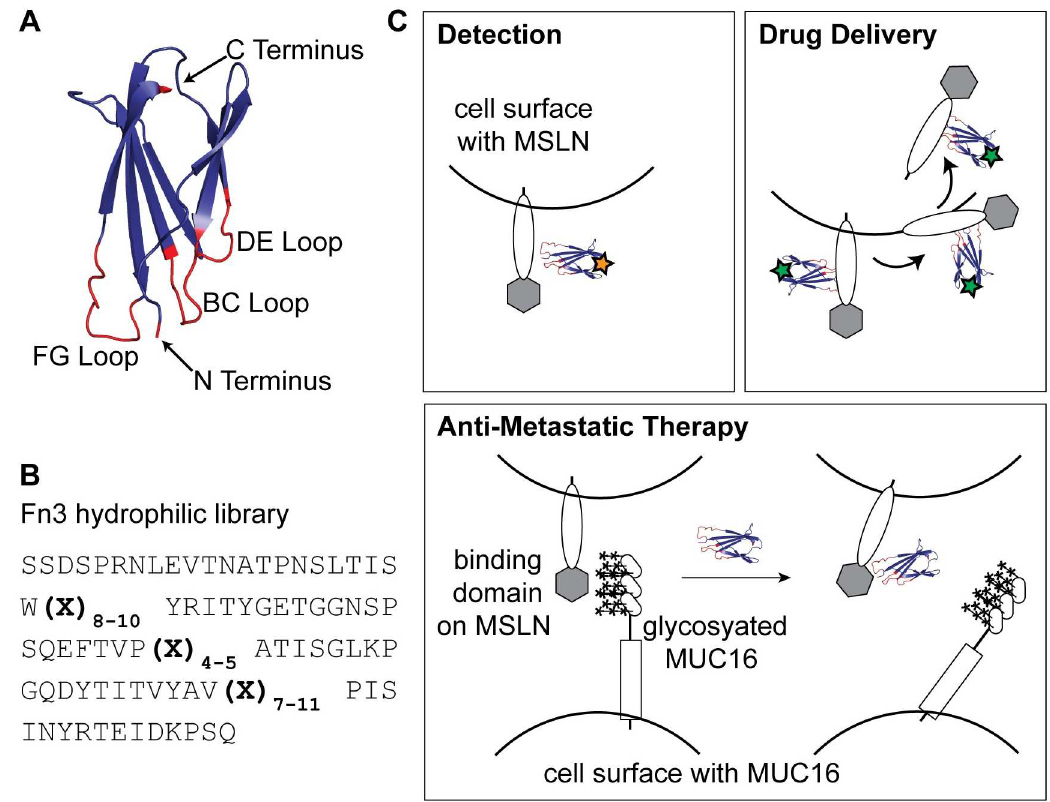
Fig 1. Approach to engineering Fn3 proteins to recognize tumor biomarker MSLN for diagnostic and therapeutic applications. (A) The tenth domain of human fibronectin type III (Fn3) (PDB 1TTG) is a highly stable protein structure with three loops (BC, DE, and FG) broadly tolerant of mutation to confer novel binding properties. Structure was rendered in PyMOL. (B) We employed a previously developed hydrophilic Fn3 yeast surface display library [56] that incorporates a range of loop lengths and biased amino acid composition to mimic the diversity of naturally occurring antibody complementarity-determining regions. (C) Fn3 proteins that bind cell surface protein MSLN have numerous potential clinical applications, such as through diagnostic imaging, internalization for drug delivery, and metastatic reduction by blocking MSLN-MUC16 interactions. Stars represent conjugated imaging or therapeutic